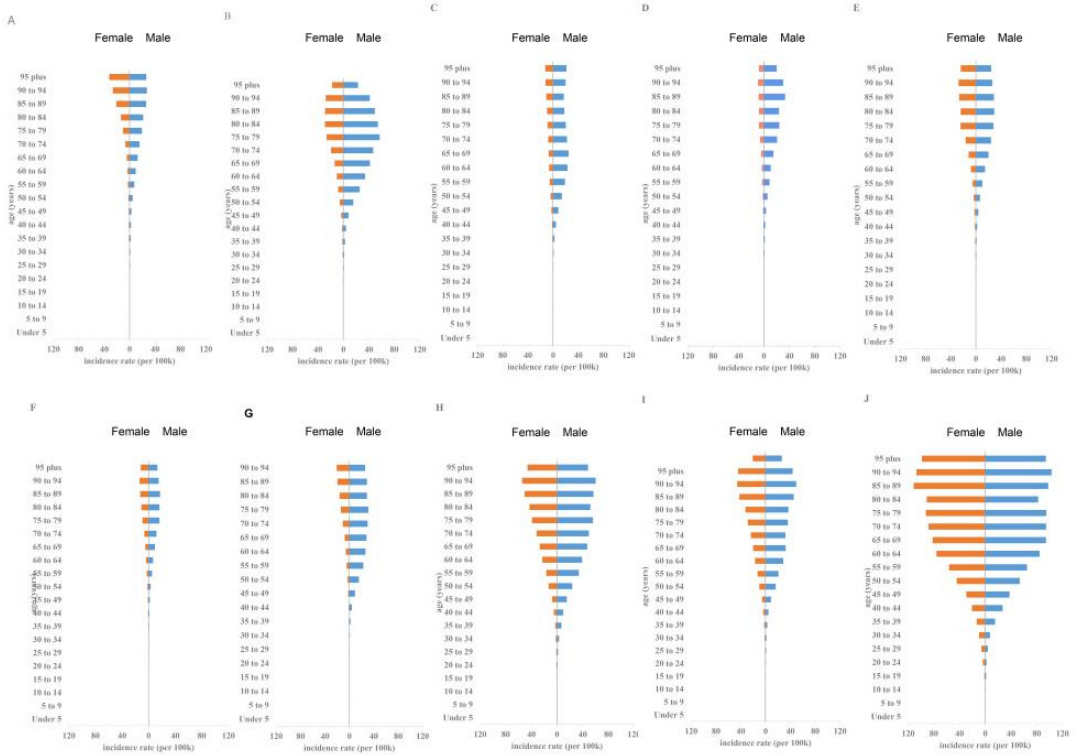
Figure 3. The incidence rates of OC in different age groups in 2019. ( A ) Japan, ( B ) USA, ( C ) Russian, ( D ) China, ( E ) Indonesia, ( F ) Mexico, ( G ) Brazil, ( H ) India, ( I ) Bangladesh, ( J ) Pakistan. (Countries are ranked from highest to lowest in